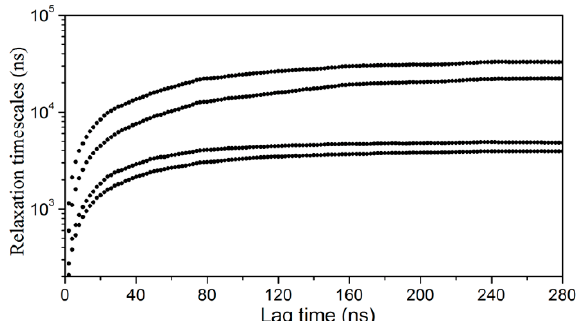
Figure 4. Implied time scale plot as a function of lag time for a five-macrostate model.